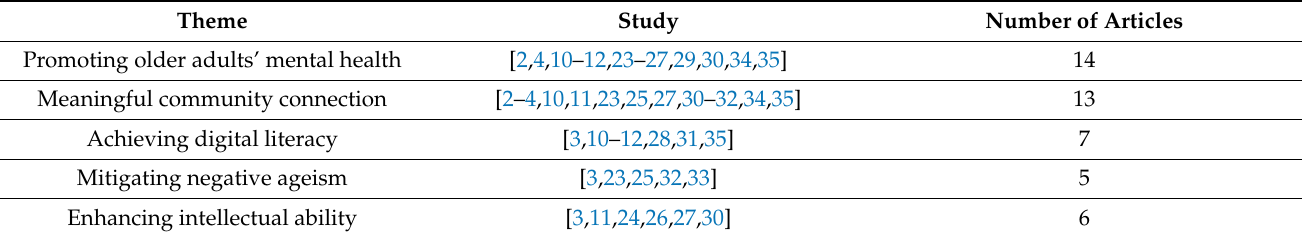
Table 3. Articles included in thematic